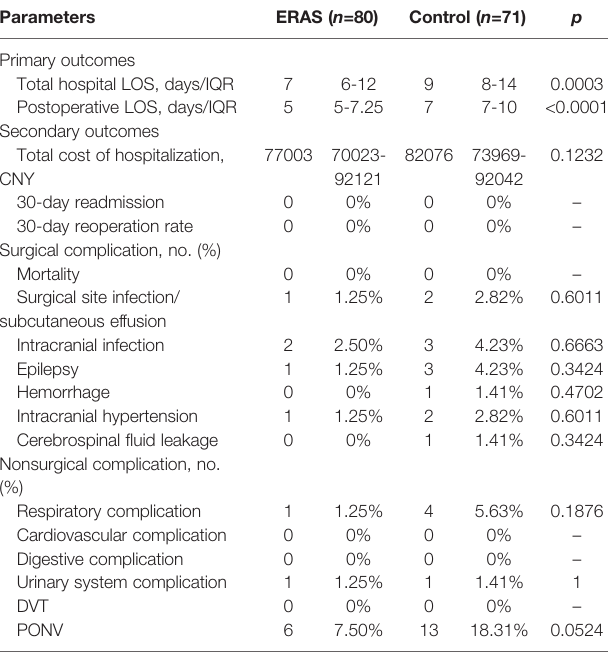
TABLE 4 | Primary outcomes and secondary outcomes between ERAS group and control group. Parameters